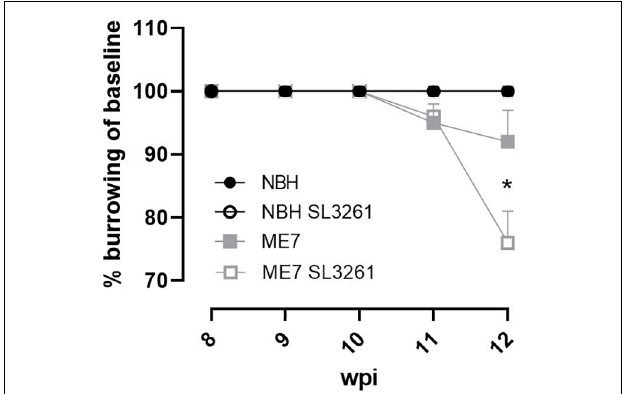
FIGURE 6 | Burrowing activity. The impact of systemic bacterial infection on burrowing behaviors in ME7 prion mice. ME7 prion mice were challenged with saline (closed squares) or 1 × 10 6 colony forming units S. typhimurium SL3261 (open squares) at 8 weeks after inoculation and followed for 4 weeks. NBH-injected mice were included as control. * p < 0.05 using one-way ANOVA with Holm-Sidak test for multiple comparisons; n = 4–5/group.